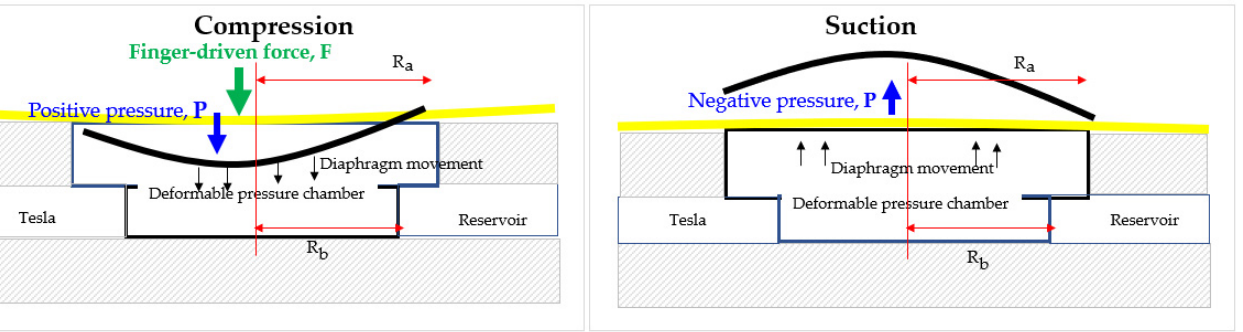
Figure 2. Schematic diagram of compression and suction mode in fi nger-actuated micropump.